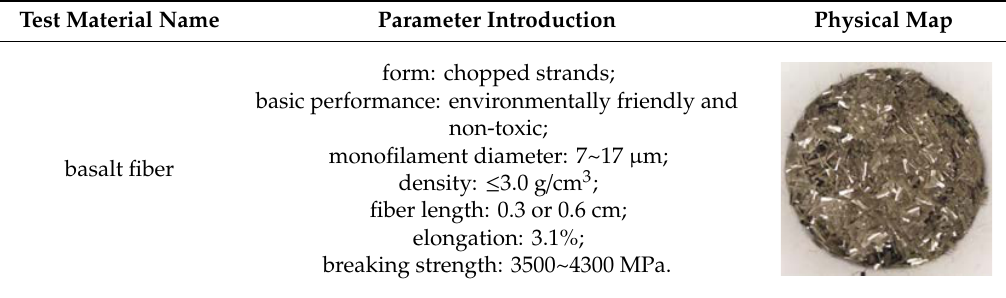
Table 2. Basalt fiber basic parameter table.